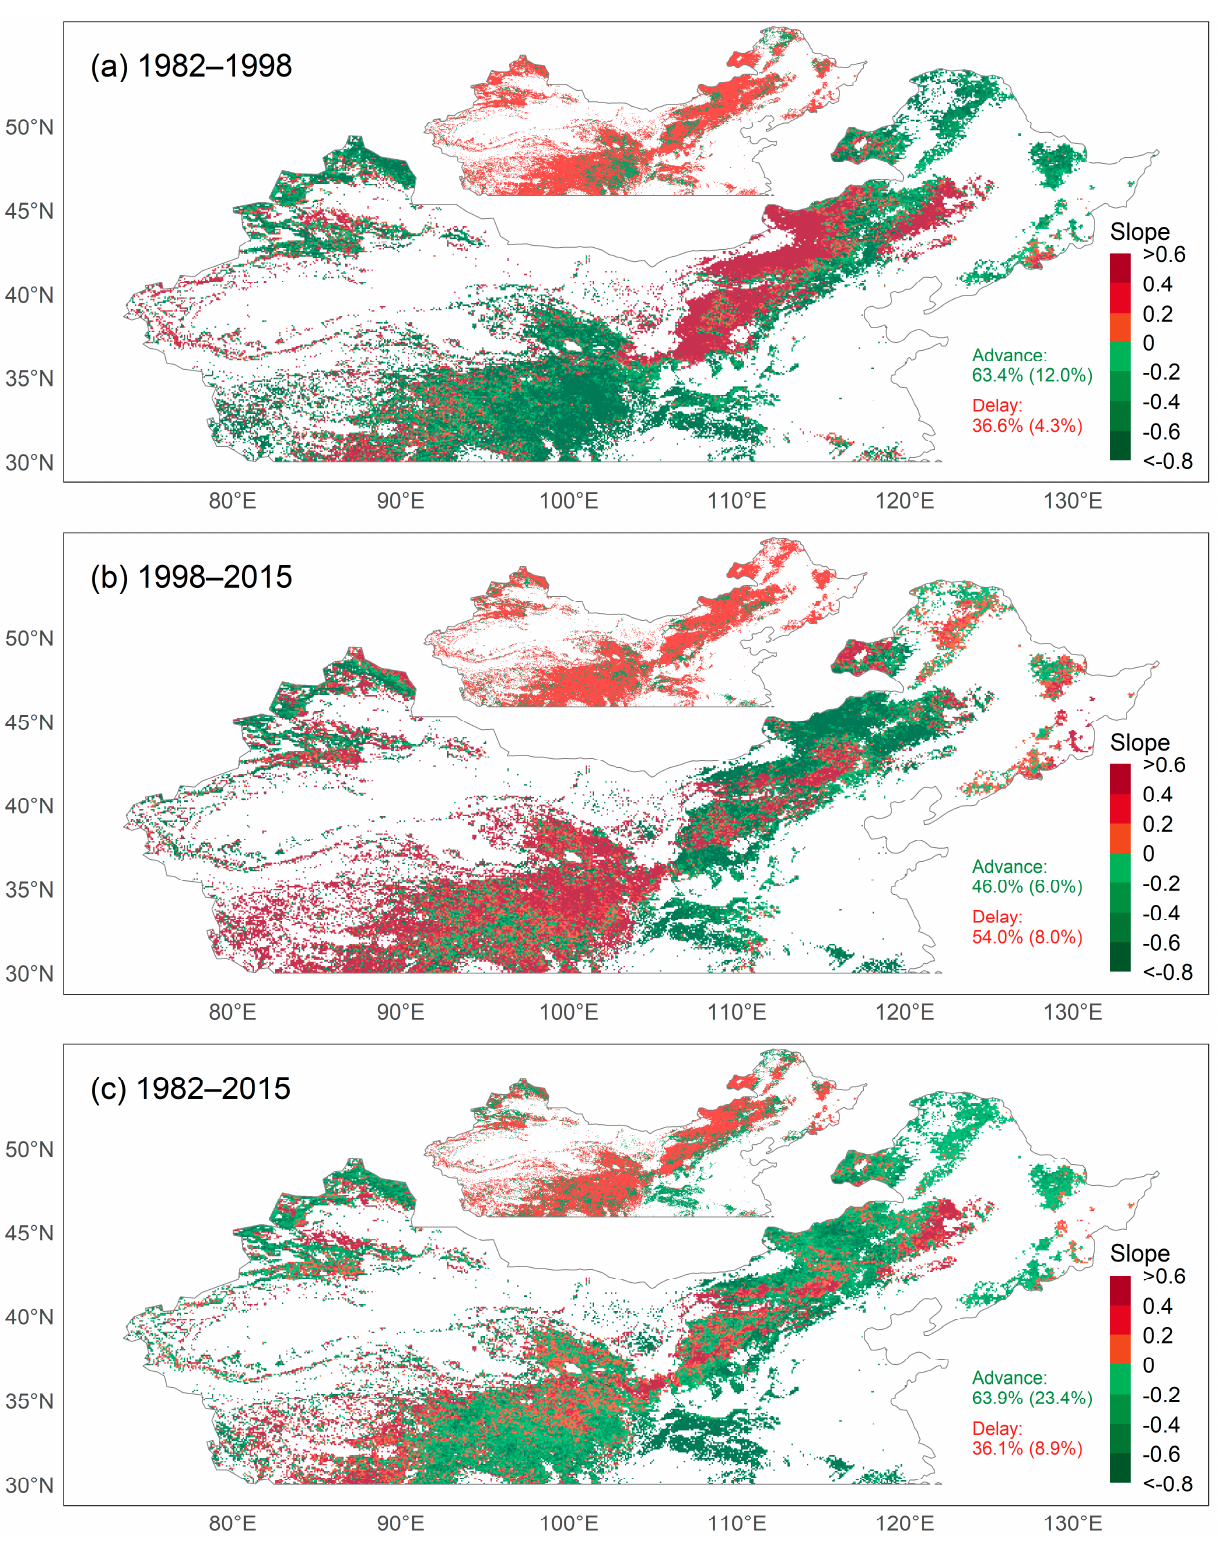
Figure 3. Map of temporal trends of the start of the growing season (SOS) during ( a ) 1982–1998, ( b ) 1998–2015, and ( c ) 1982–2015. The insets show the pixels with p ≥ 0.05 (red) and p < 0.05 (green). Percentages indicate the proportion of pixels with advanced or delayed SOS (percentage of pixels with p value < 0.05 in parentheses).